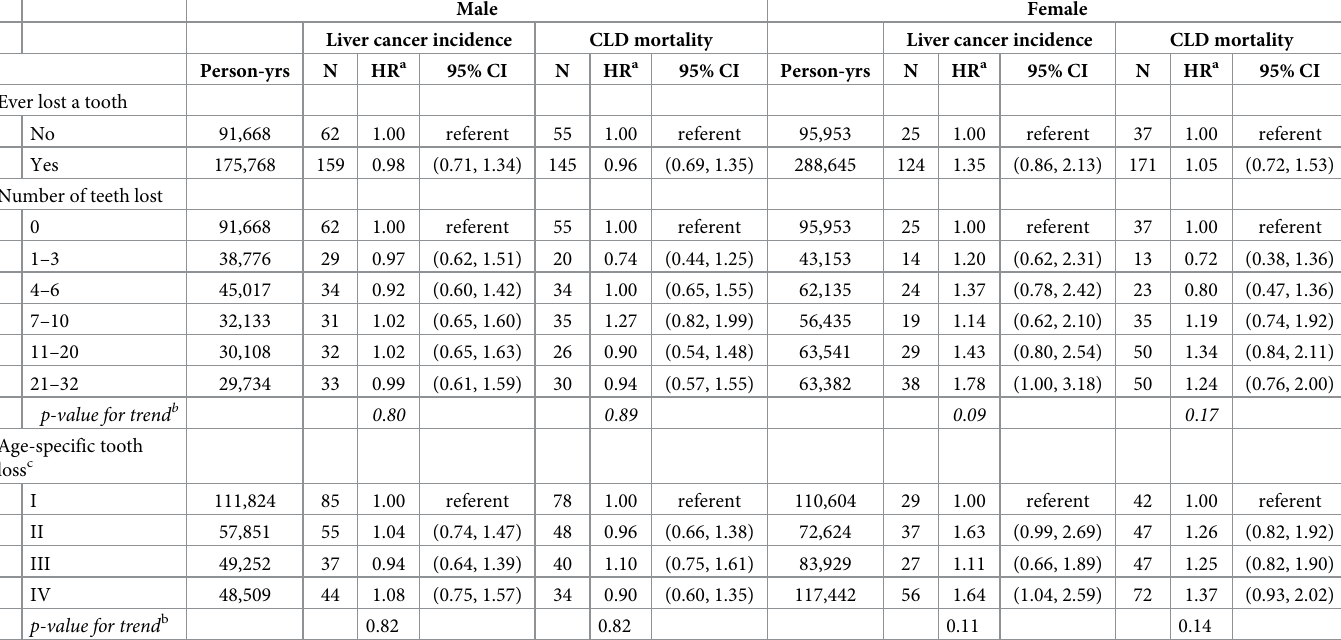
Table 3. Association of tooth loss to incident liver cancer and chronic liver disease (CLD) mortality by gender in the Nutrition Intervention Trials Cohort, Linxian, China,